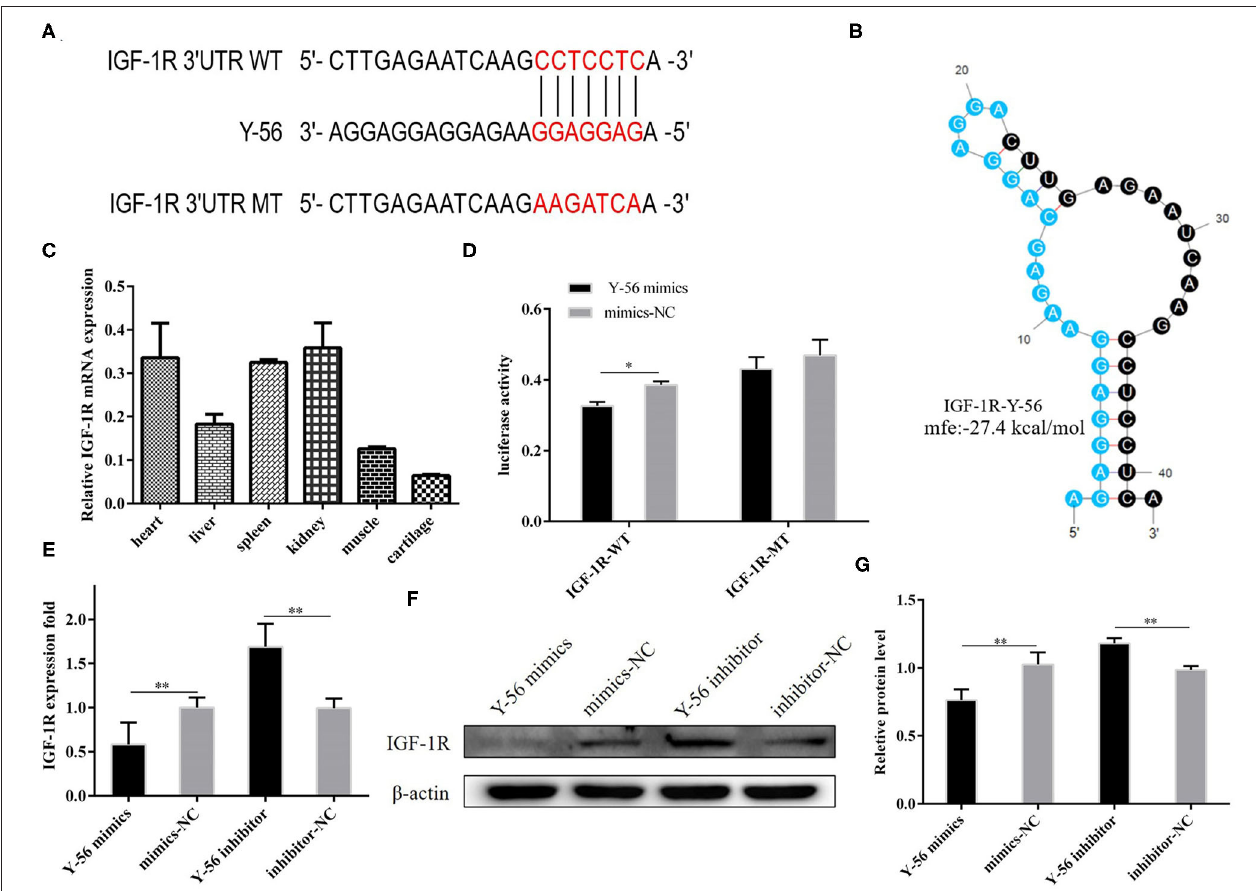
FIGURE 4 | IGF-1R is the direct target gene of Y-56. (A) Y-56 binding site in the IGF-1R mRNA 3 ′ UTR. (B) Potential secondary structures formed by Y-56 binding to IGF-1R mRNA 3 ′ UTR. (C) Relative mRNA expression of IGF-1R in different porcine tissues. (D) Dual-luciferase reporter assay of the co-transfection of wild-type or mutant IGF-1R 3 ′ UTR with Y-56 mimics or mimics-NC in 293T cells. (E–G) MRNA and protein levels of IGF-1R in PSCs after transfection with Y-56 mimics or Y-56 inhibitor (* P < 0.05, ** P < 0.01, and *** P <